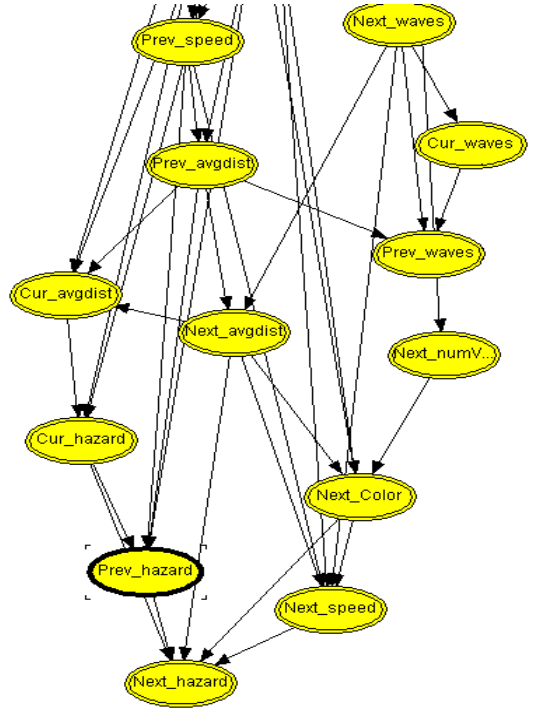
Figure 12. A fragment of the trained Bayesian network.